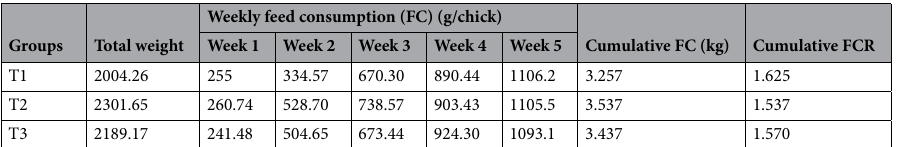
Table 2. Effect of ZnONPs supplementation on total body weight (g), feed consumption (FC), cumulative feed conversion ratio (FCR) and performance index (PI) of broiler chicks.